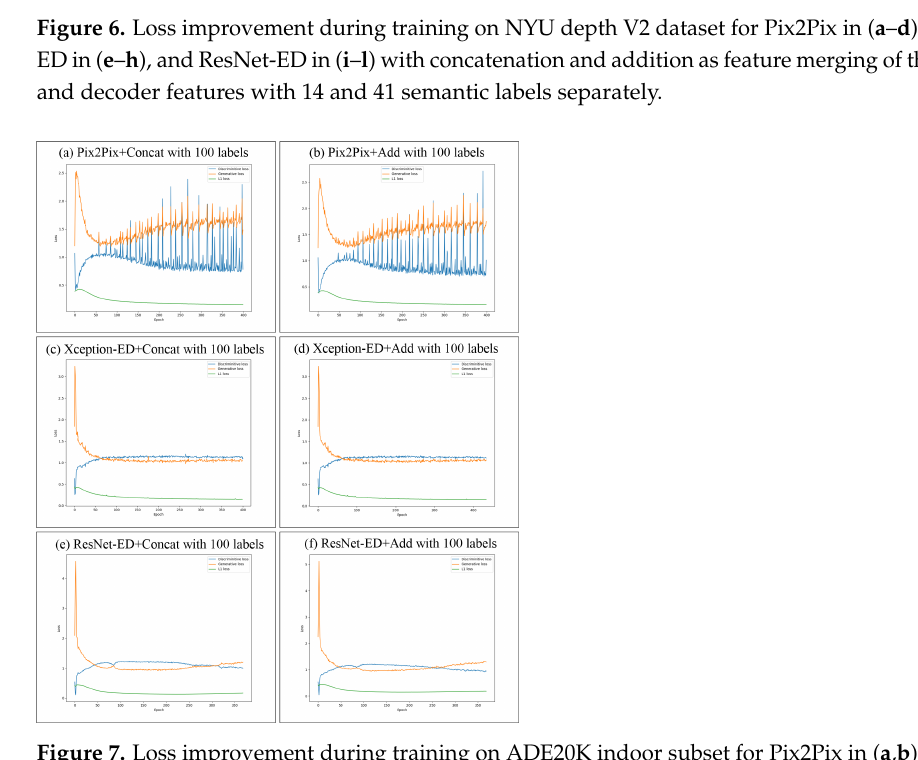
Figure 7. Loss improvement during training on ADE20K indoor subset for Pix2Pix in ( a , b ), Xception- ED in ( c , d ), and ResNet-ED in ( e , f ) with concatenation and addition as feature merging of the encoder and decoder features with 100 semantic